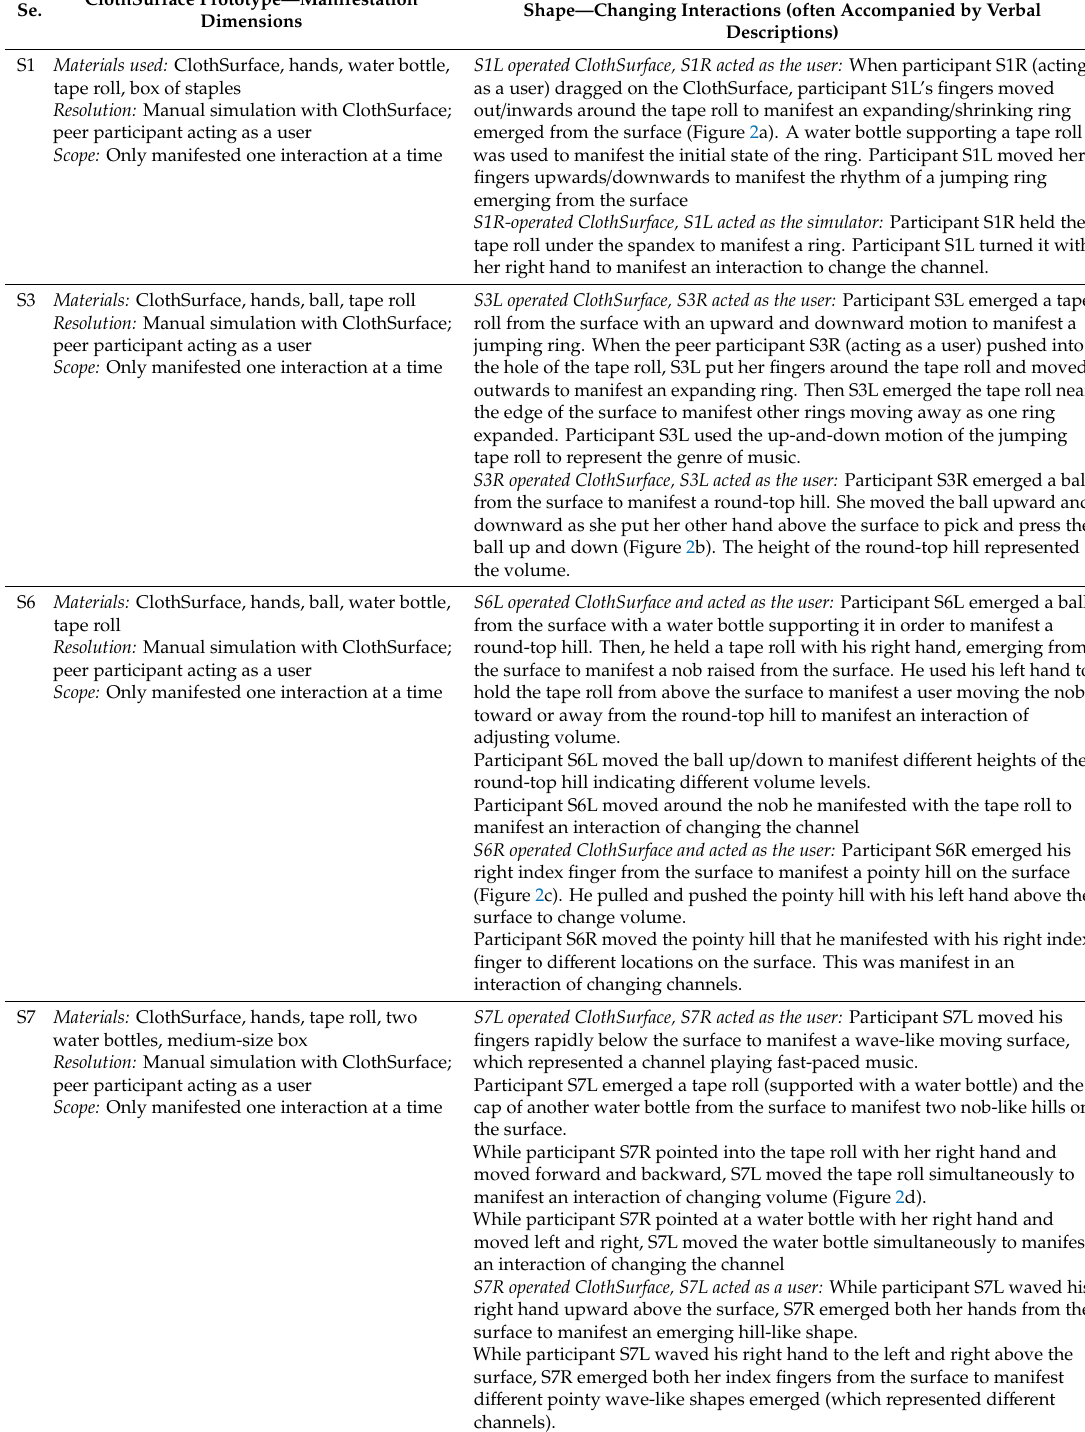
Table 1. Manifestation Dimensions and Use of Materials in the Sessions Assigned to the Radio Design Tasks (1A & 1B)